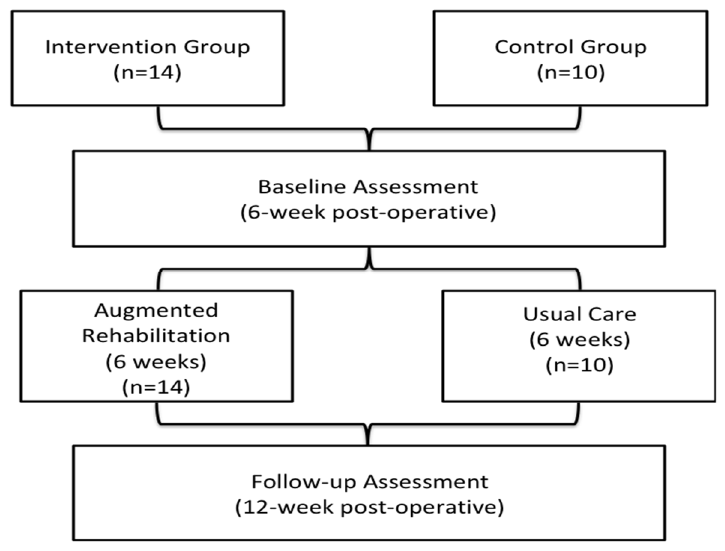
Figure 1. Study Flow chart.